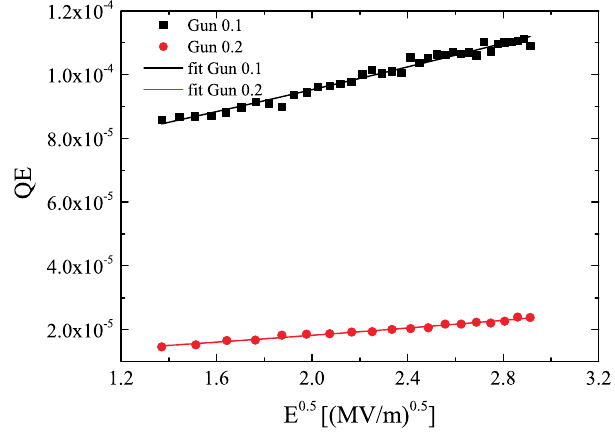
FIG. 11. QE dependence on the square root of the field gra- dient on the cathode surface and for Gun 0.1 (squares) and Gun 0.2 (circles). The continuous lines are the fitting